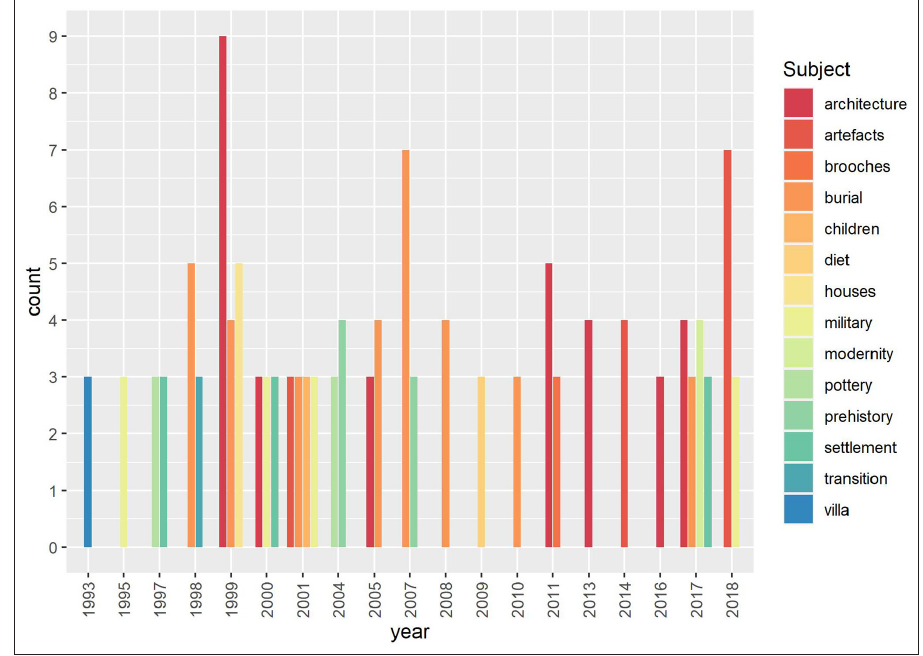
Figure 9: Frequency of ‘subject’ key words used in publications per year (all terms used more than three times per year are